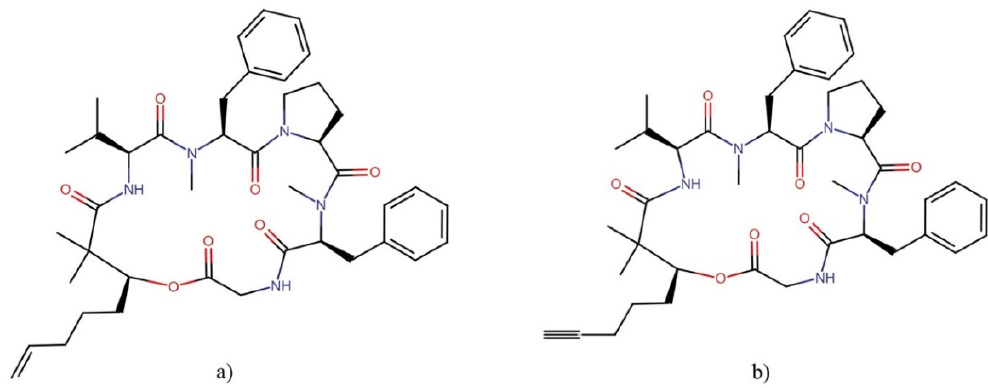
Figure 9. Chemical structures of ( a ) cocosamide A and ( b ) cocosamide B.